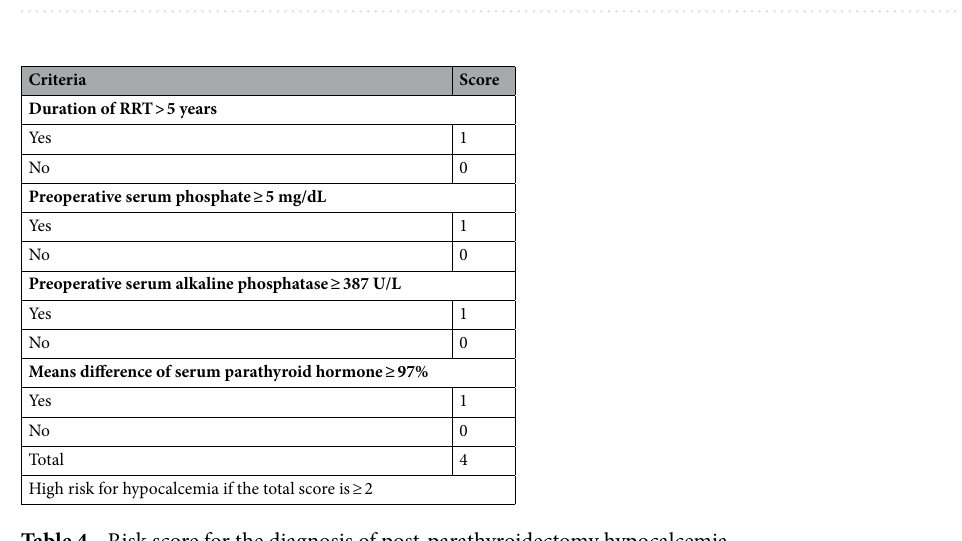
Figure 2. ROC and Area under ROC (AuROC) for the prediction of hypocalcemia after parathyroidectomy. Area under the receiver operating characteristic (AuROC) curve of hypocalcemia after parathyroidectomy predicted by predictive model (solid line), predictive risk score (dash line), and 50% chance prediction (diagonal line).